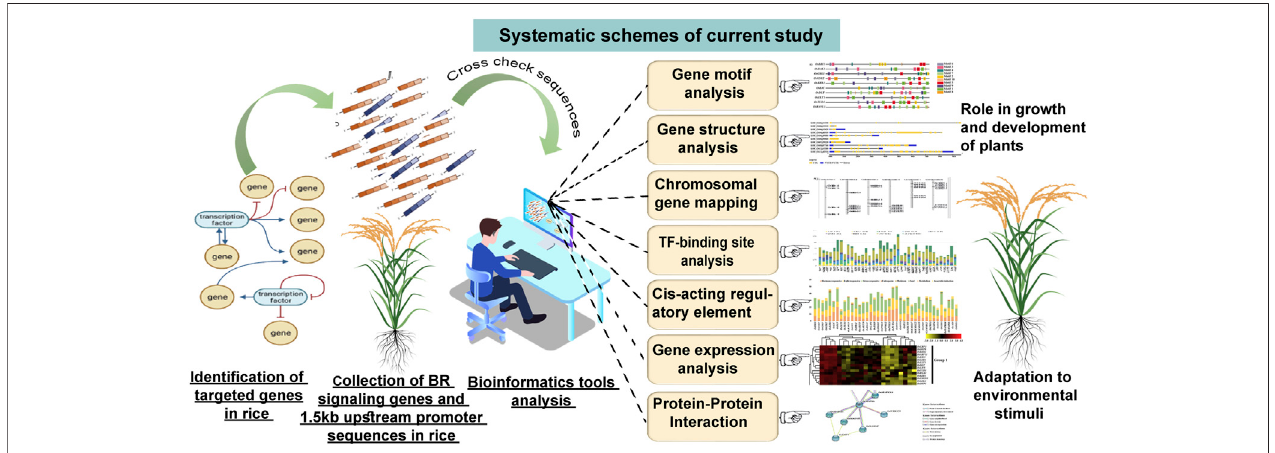
FIGURE 1 | Systematic representation of current